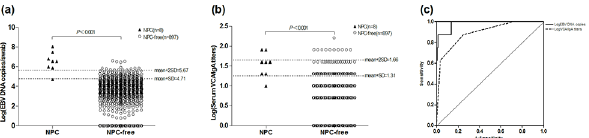
Fig 3. Diagnostic performance of EBV load and VCA/IgA titers. Cut-off values (COV) and areas under receiver operating characteristic (ROC) curves were calculated to evaluate the diagnostic performance of EBV load and VCA/IgA titers. (a) The optimal COV for EBV load was mean plus 2 standard deviations (i.e. 4.7×10 5 copies/swab); (b) The best COV for VCA/IgA titers was mean plus standard deviation (i.e. 1:20); (c) The ROC curve indicated that EBV load had a better diagnostic value than VCA/IgA titers; the area under the curve of EBV load was larger than VCA/IgA